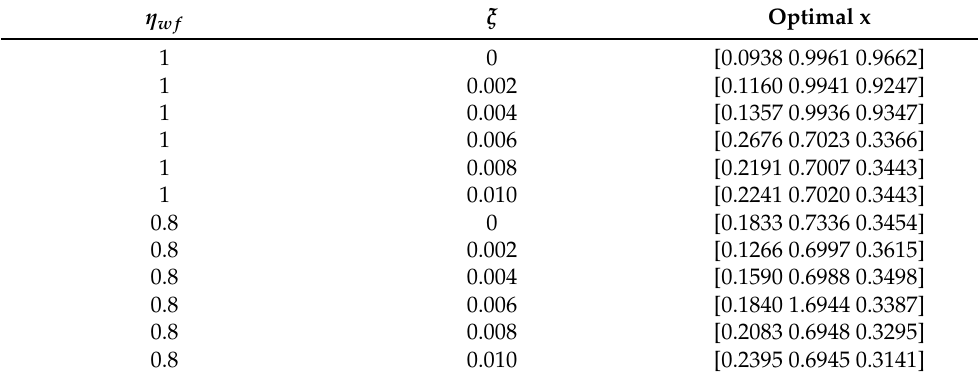
Table 4. PSO summary for one mandate (4